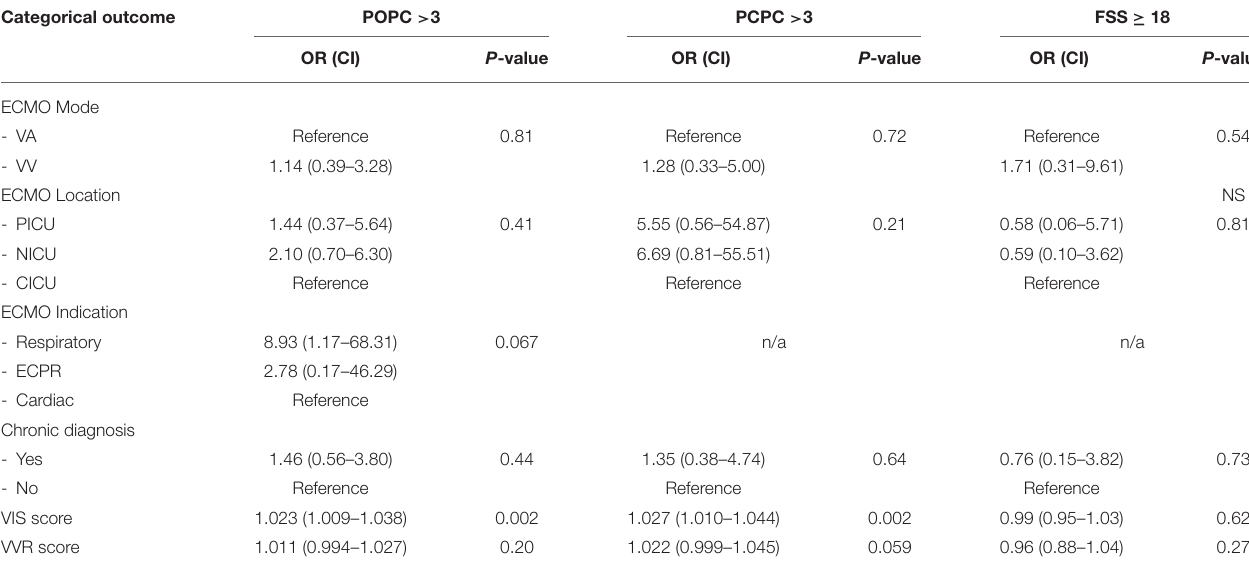
TABLE 3 | Logistic regression of association of Predictor Variables with an unfavorable functional outcome in survivors. Categorical outcome